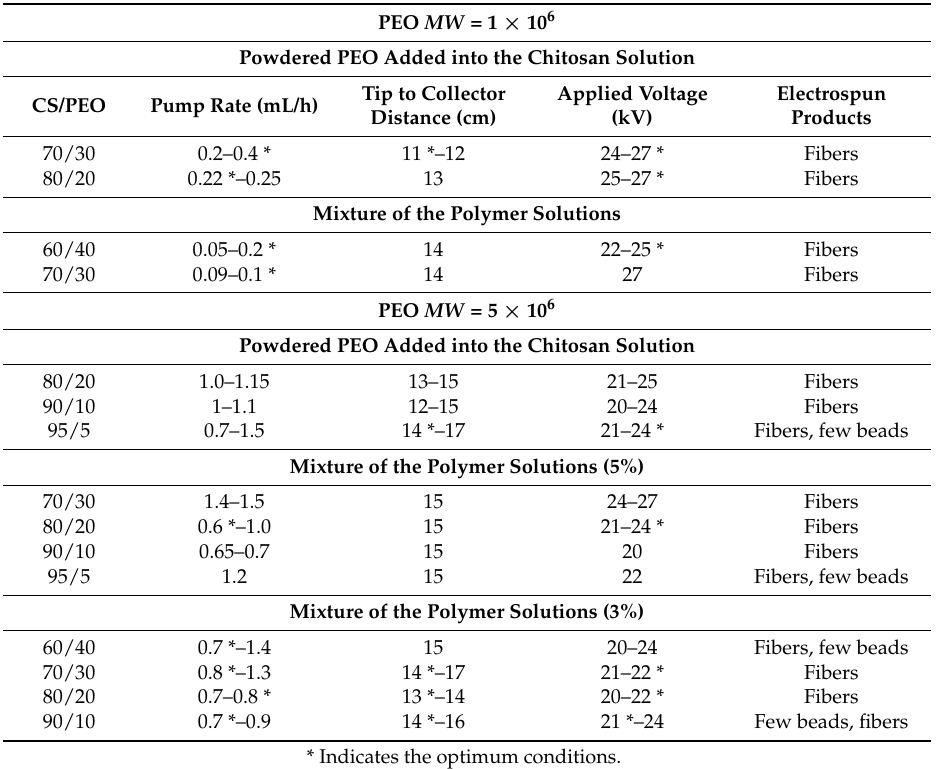
Table 4. Experimental conditions for electrospinning on the different systems